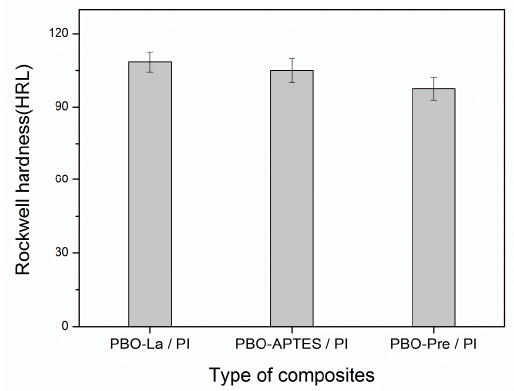
Figure 10. The hardness of the three composites at room temperature.